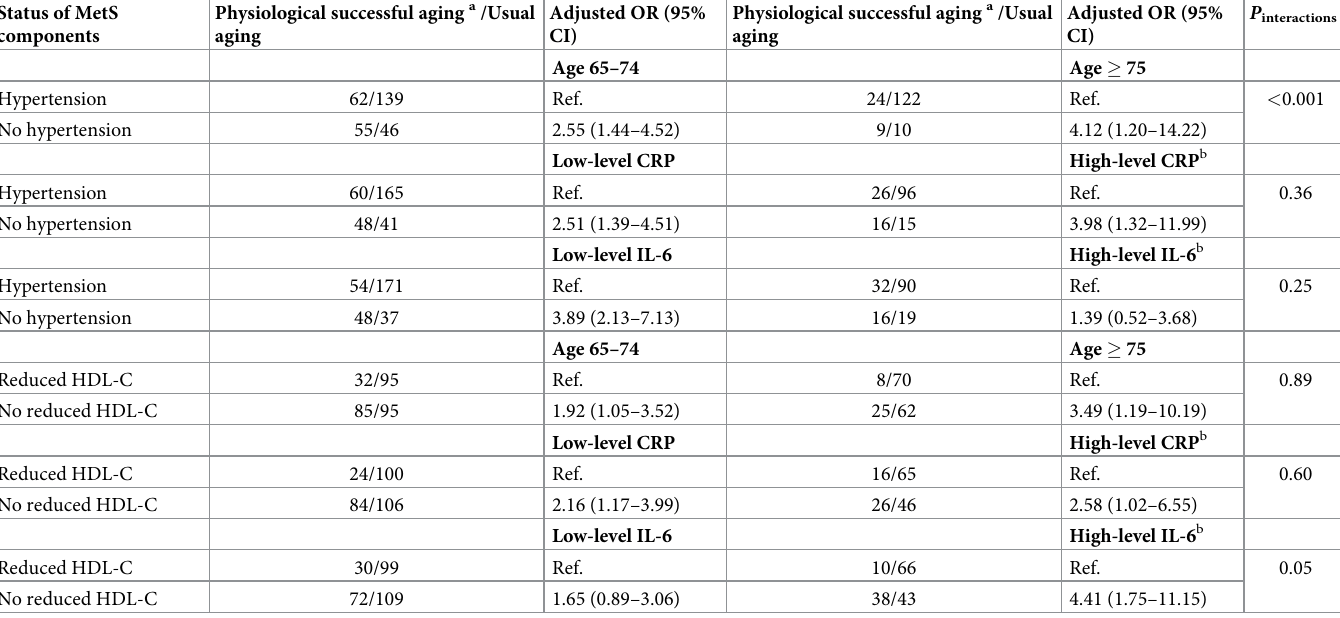
Table 3. The associations of hypertension and HDL-C with physiological successful aging over six years stratified by important variables (baseline age, CRP, and IL-6).